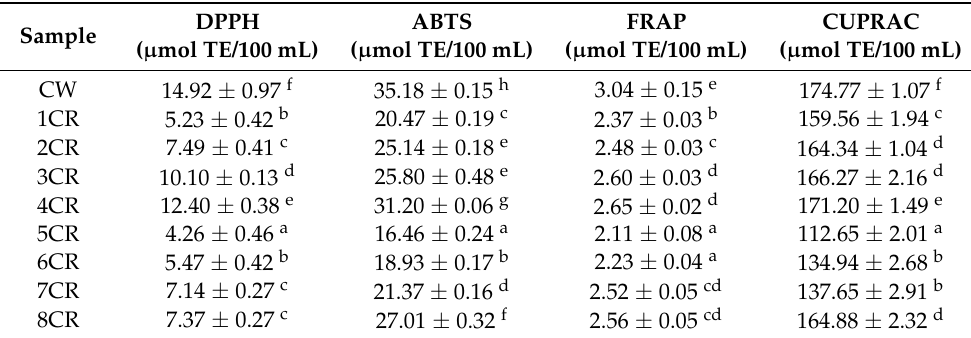
Table 7. Antioxidant activity determined by DPPH, ABTS, FRAP, and CUPRAC in initial conventional Cabernet Sauvignon wine and retentates obtained by reverse osmosis at 2.5, 3.5, 4.5, and 5.5 MPa with cooling and without cooling.